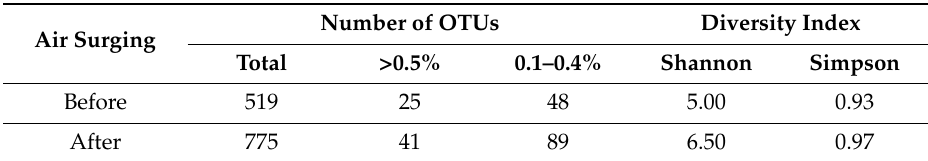
Table 1. A comparison of operational taxonomic units (OTUs) and diversity indices before and after air surging. The percentages indicate a prevalence rate.